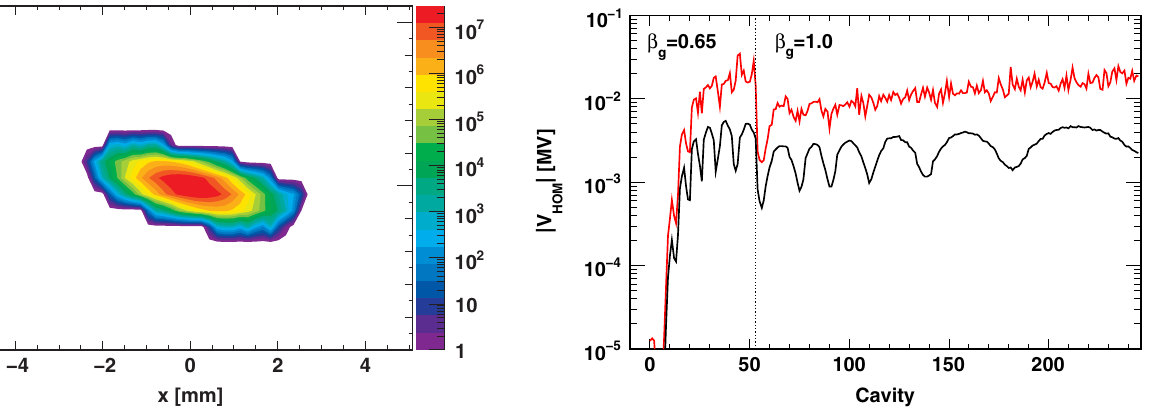
FIG. 26. 2D phase space plot of the second pulse at the exit of the linac with one dipole mode present for 1000 linacs. Settings: N ¼ 1000 , see Table IX.